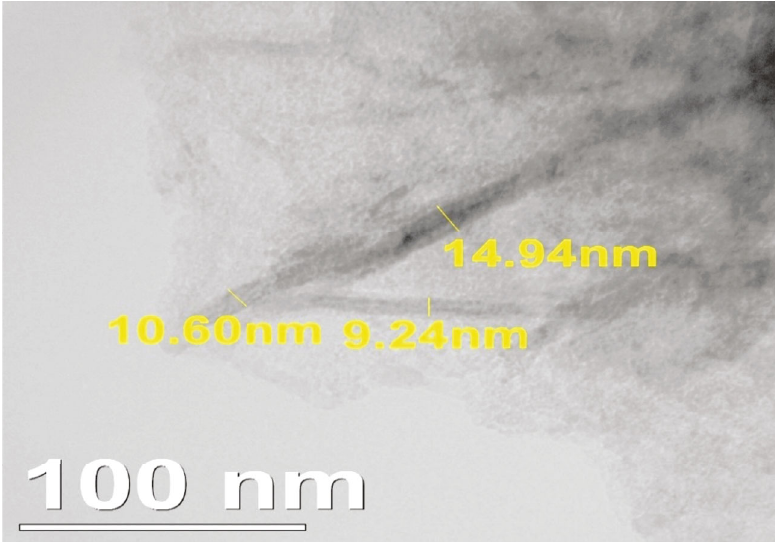
Figure 7: TEM image of MgO.